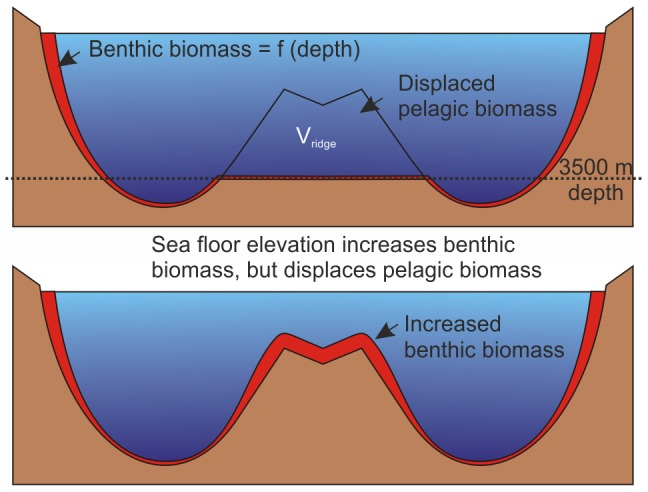
Effect of a ridge on mid-ocean biomass.Comparison of sections of a hypothetical ocean with the MAR truncated at the 3500 m depth horizon (upper panel) with the real ocean with a ridge present (lower panel). The thickness of the red section indicates the benthic biomass that decreases with depth. Vridge is the volume of water, including pelagic biomass displaced by the ridge.